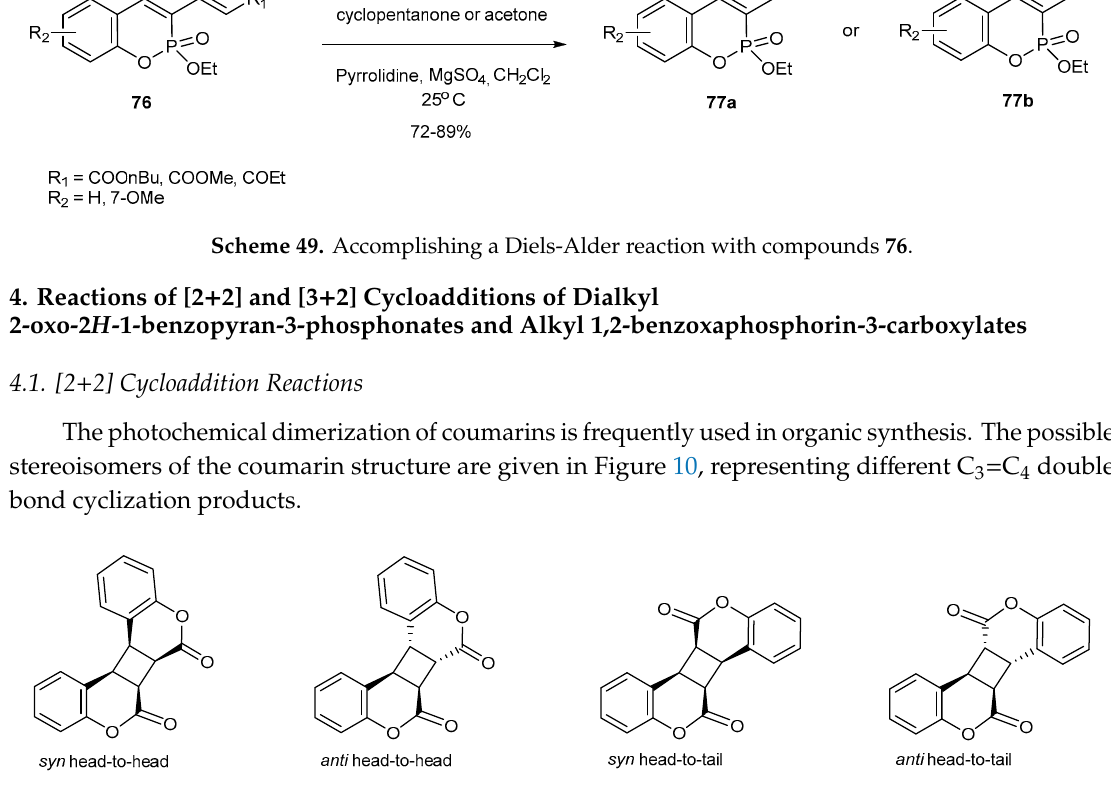
Figure 10. Cyclized stereoisomers.